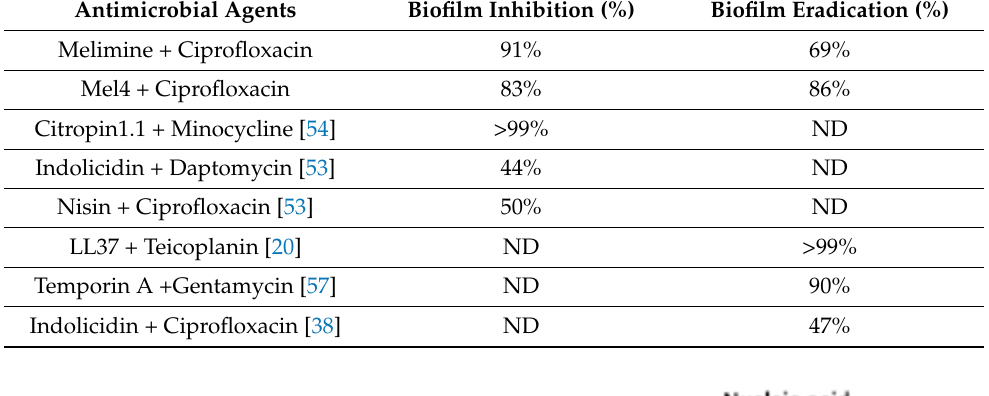
Table 2. Effect of antimicrobial peptides and antibiotics at 0.5X MIC in combination against S. aureus biofilm.